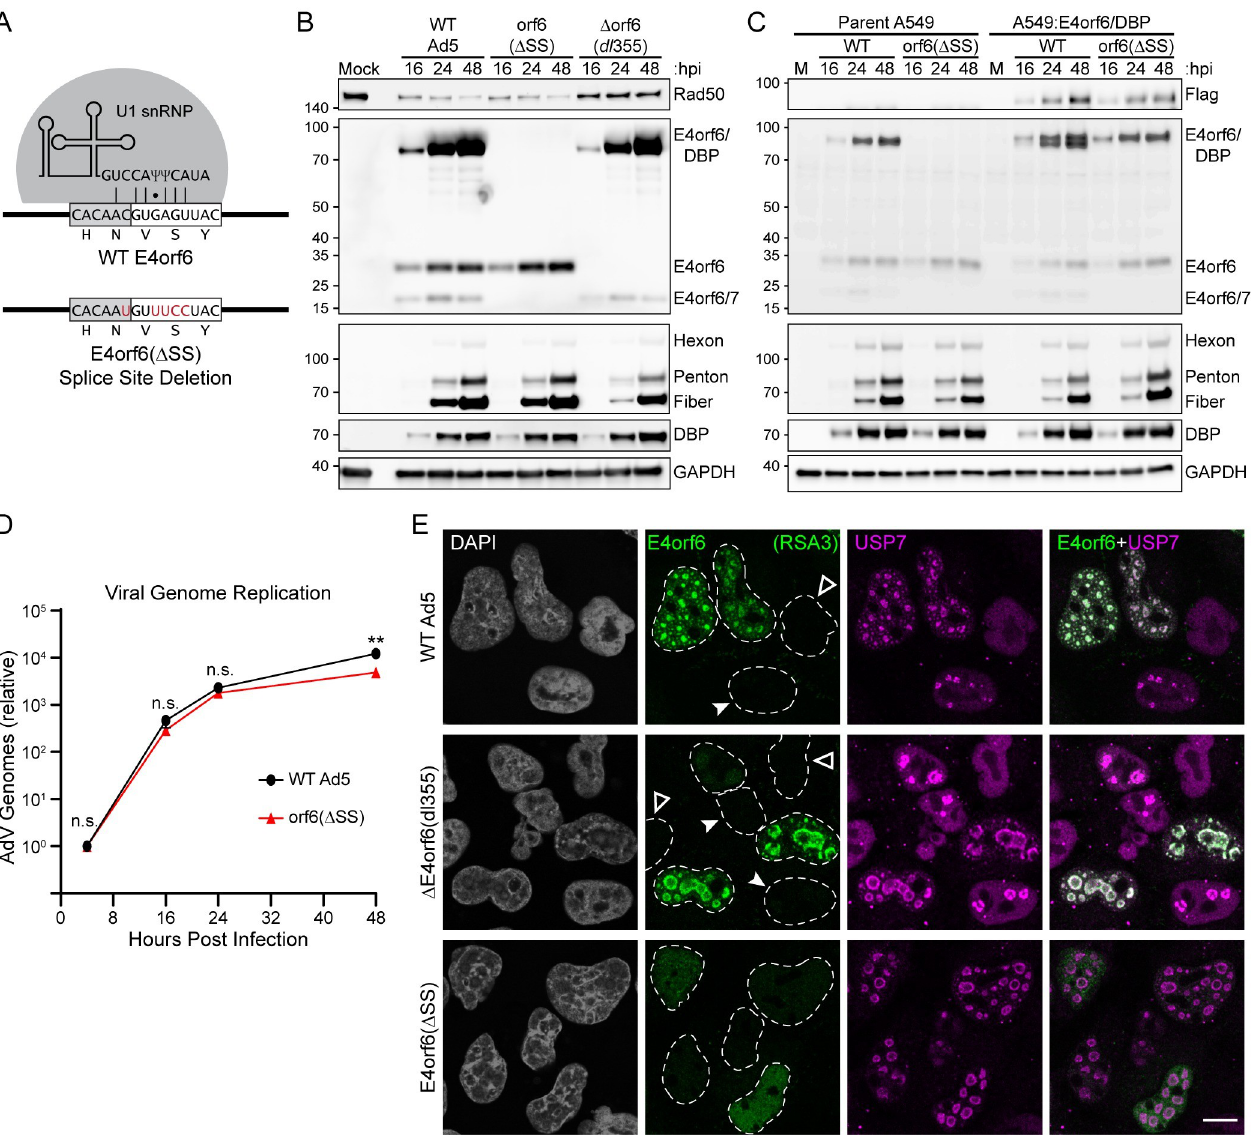
Fig 6. Loss of E4orf6/DBP has minimal impact on viral genome replication or protein expression. (A) E4orf6 splice donor is recognized by base-pairing to the cellular U1 snRNP. Silent mutations shown in red abrogate downstream splicing and were used to create the E4orf6/7, E4orf6/DBP double knockout virus (E4orf6 Δ SS). (B) A549 cells were infected with WT Ad5, E4orf6 Δ SS, or Δ E4orf6 ( dl 355) and harvested over a time-course of infection (hpi, hours post- infection). Immunoblot analysis was performed with antibodies to detect the indicated viral and cellular proteins. Kilodalton size markers are shown to the left of each blot. (C) Immunoblot analysis of a time-course infection was performed as in panel B . Cell lines were parent A549 or A549 transduced to express flag- E4orf6/DBP under control of the adenoviral E4 promoter. (D) A549 cells were infected with WT Ad5 or E4orf6 Δ SS in biological triplicate. Adenoviral genome copy number was determined by qPCR and normalized to the amount of input genomes at 4 hpi. Significance was determined by unpaired, two-tailed t-test (n.s., not significant; �� , p-value < 0.01). (E) A549 cells were infected with WT Ad5, Δ E4orf6, or E4orf6 Δ SS for 24 hours before immunofluorescence was performed. Cells were stained with antibodies against E4orf6 N terminal domain (RSA3, green) or cellular USP7 as a marker of viral replication centers (magenta). Dashed white lines outline the nuclear periphery. Open white arrowheads denote uninfected cells with diffuse USP7 and no viral staining, while closed arrowheads denote infected cells that lack E4orf6 staining but show USP7 at viral replication centers. White scale bar denotes 10 μ